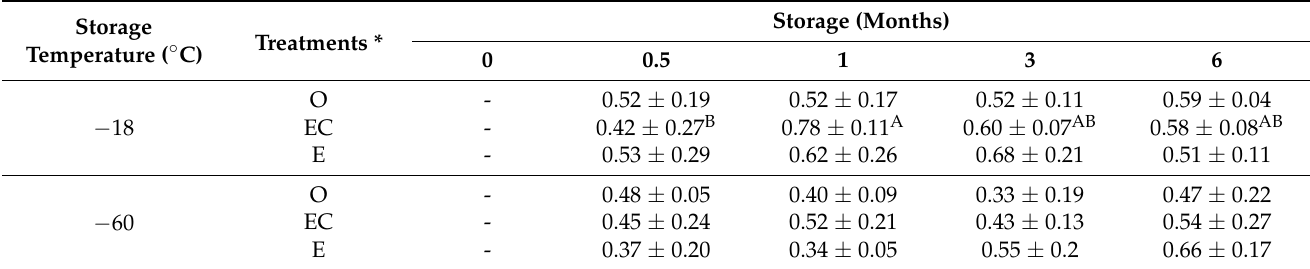
Table 3. Drip loss (%) of meat analogs with different fat replacers (O, EC, and E) during the freezing storage ( − 18 ◦ C, − 60 ◦ C) for six months.